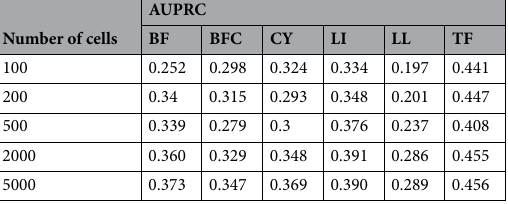
Table 3. The AUPRC for datasets with different types and containing different numbers of cells.